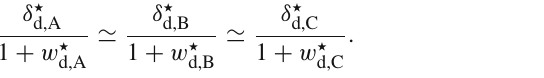
Fig. 2 These plots represent the relative deviation with respect to the = 1. The top, middle and bottom panels corre- result given when c 2 s d spond with the models A, B and C, respectively. The left panels show the results for the matter power spectrum as a function of the mode. The right panels show the results for f σ 8 in terms of redshift, z . Different